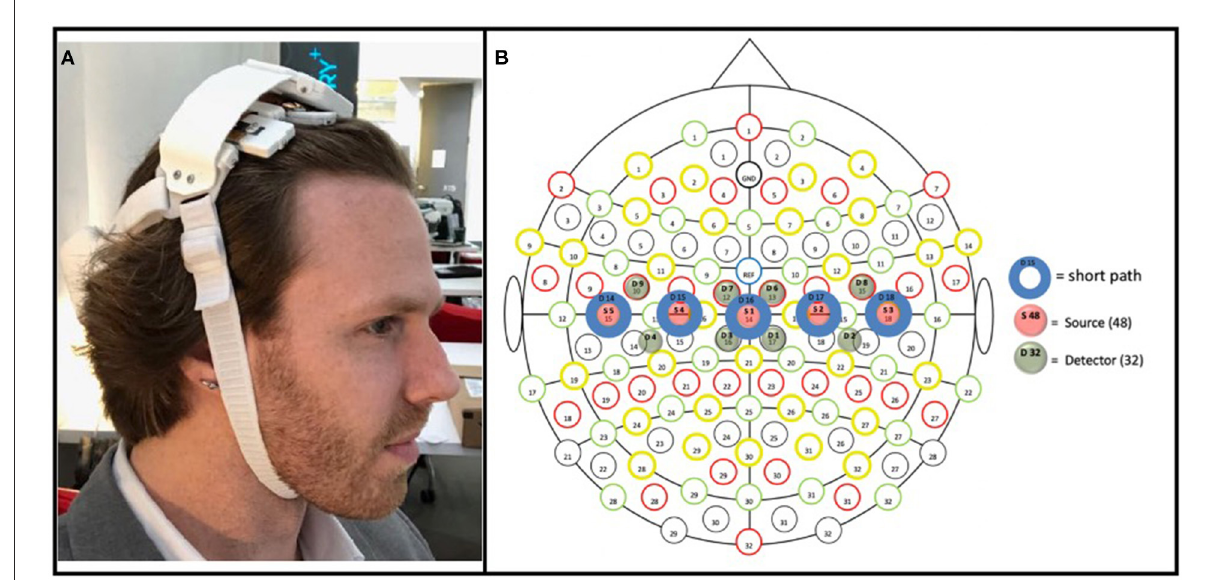
FIGURE3 (A) Prototype fNIRS headband used in the present study. As pictured, the headband’s battery was housed on the back of the head, connected by a strap to the main headband unit; a controller PCB sat above the flexible measurement components (which interfaced with the hair/scalp); and the device was held in place by a chin strap. (B) Array of optical components included in the prototype fNIRS headband. Blue circles (D14–D18) represent detectors; green circles (D1–D9) represent long-path LEDs (positioned 3cm from adjacent detectors); red circles represent short-path (positioned 8mm from its adjacent detector). The three medial detectors (D15, D16, and D17), being 3cm from four long-path LEDs (e.g., D15 was 3cm from D3, D4, D7, and D9), thus enabled four measurement locations each, with the two detectors on either end (D14 and D18), being 3cm from two long-path LEDs, enabled two measurement locations; resulting in a total of 16 measurement